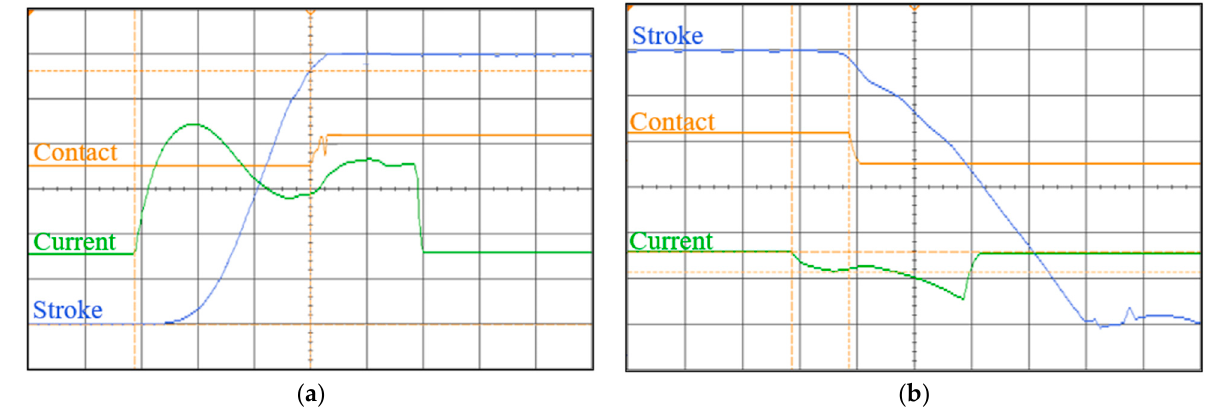
Figure 17. Characteristics of ( a ) closing and ( b ) opening operations. Table 4. Specifications of designed prototype.